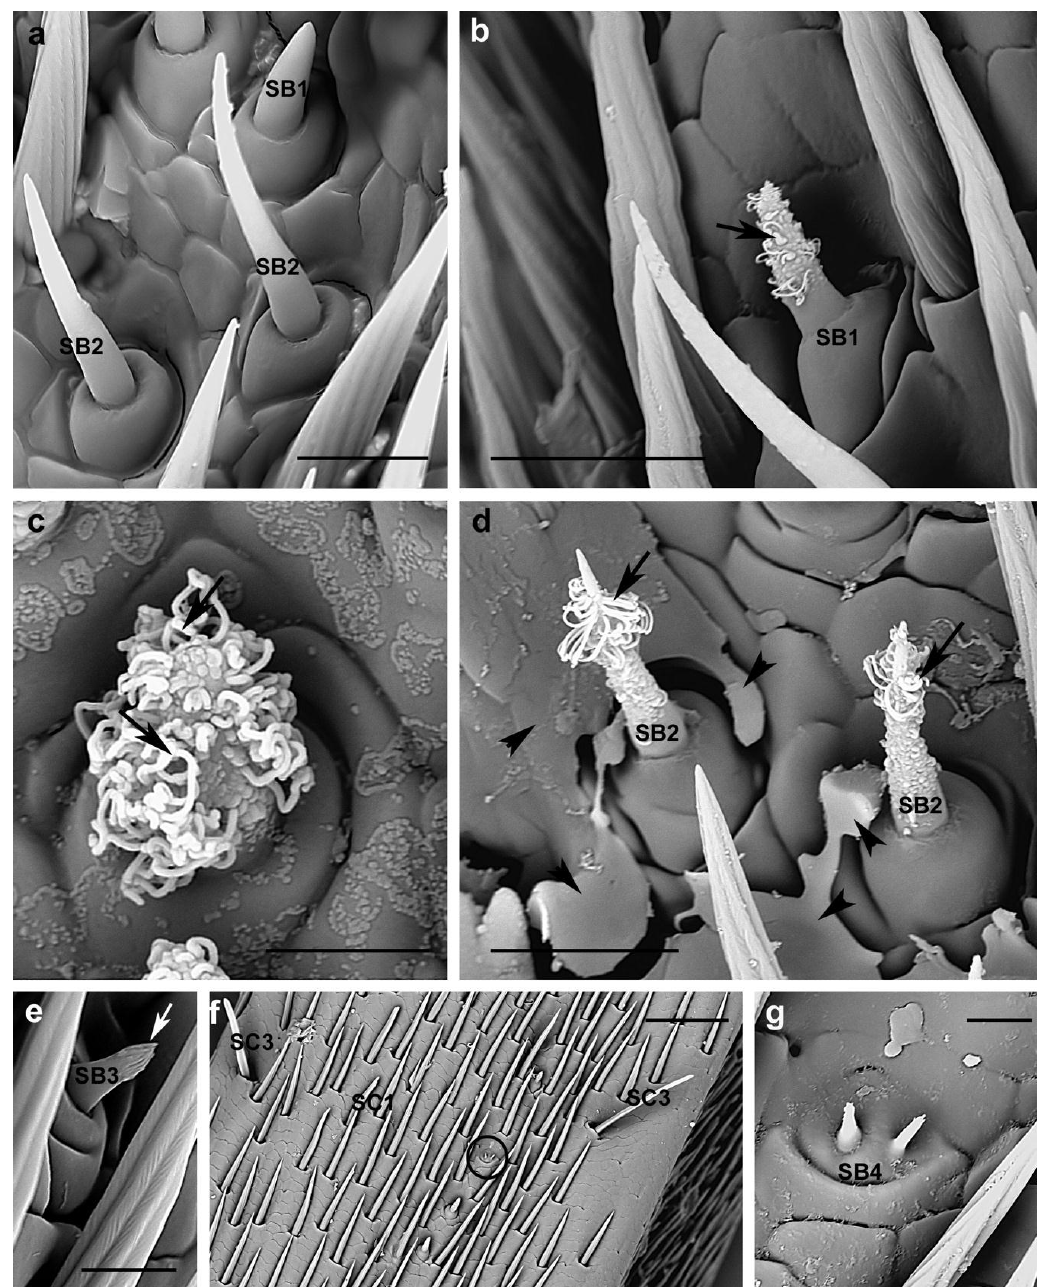
Figure 10. A. bungii , SEM. Sensilla basiconica. ( a ) Female: SB1 and SB2. ( b ) Detail of one SB1 covered by abundant viscous material condensing outside in female and ( c ) male (arrows). ( d ) Male: Detail of two SB2 with some viscous material condensing outside their walls (arrows) and on the antennal surface (arrowheads). ( e ) Male: Detail of one SB3 with smooth base and distal finger-like projections (arrow). ( f ) Male: Overview of one SB4 (circle) visible among several SC1 and few SB2. ( g ) Male: Detail of SB4 represented by two jointed sensilla raising from the same base. Abbreviations: SB1, sensillum basiconicum type 1; SB2, sensillum basiconicum type 2; SB3, sensillum basiconicum type 3; SB4, sensillum basiconicum type 4; SC1, sensillum chaeticum type 1; SC3, sensillum chaeticum type 3. Scale bars: 10 µm ( a , b , d ); 5 µm ( c , e , g ); and 50 µm ( f ).